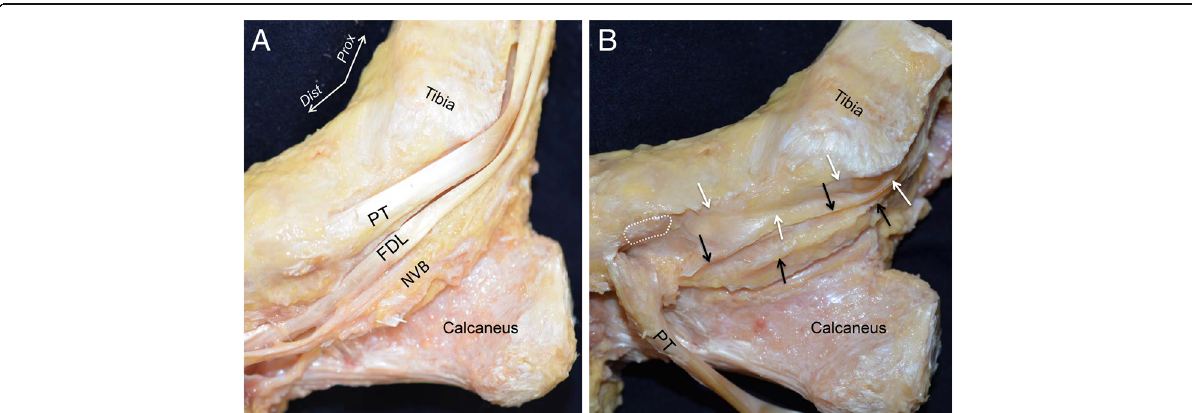
Fig. 1 Outer appearance of the medial joint capsule. a The medial side of the right ankle joint. The courses of the posterior tibialis (PT) and the flexor digitorum longus (FDL) tendons and the neurovascular bundle (NVB) are shown after removing the subcutaneous tissue and the superficial sheath of the tendons. b To expose the outer appearance of the medial joint capsule, the PT and FDL tendons and the NVB were removed. The navicular insertion of the PT ( white dotted area ) was detached and reflected in the plantar direction. The sheath floors of the PT ( white arrows ) and FDL ( black arrows ) tendons are continuously connected with the anterior part of the joint capsule. Dist , distal; Prox , proximal